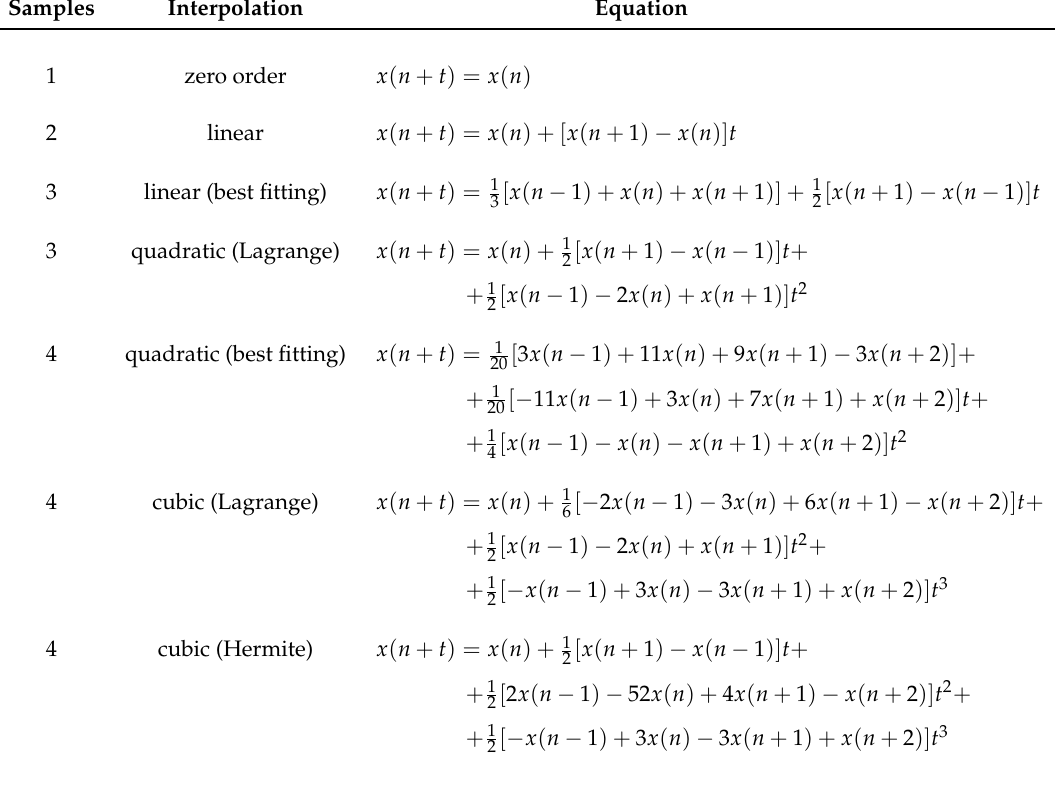
Table 1. Lagrange, Hermite and best fitting polynomial (in the sense of least square error) adopted in